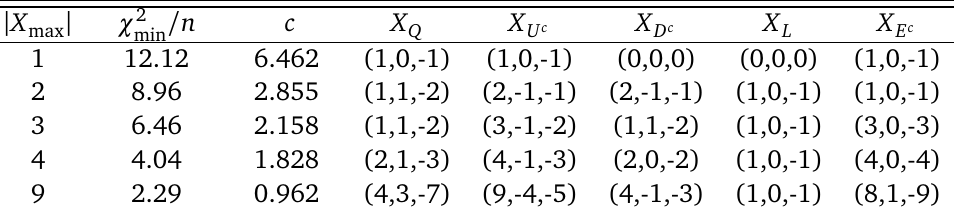
Table 3: The best fit solution for each | X | = 5,6,7,8 and 10, no new better solution is found. For | X max